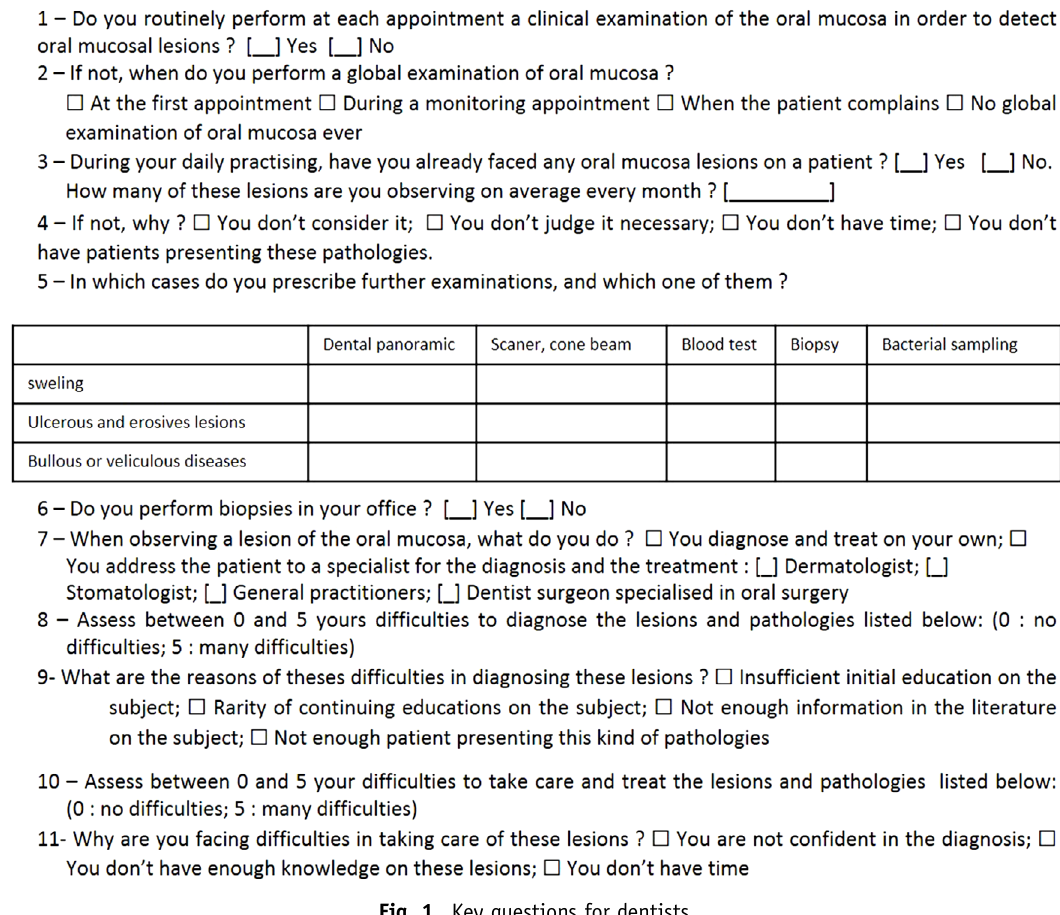
Fig. 1. Key questions for